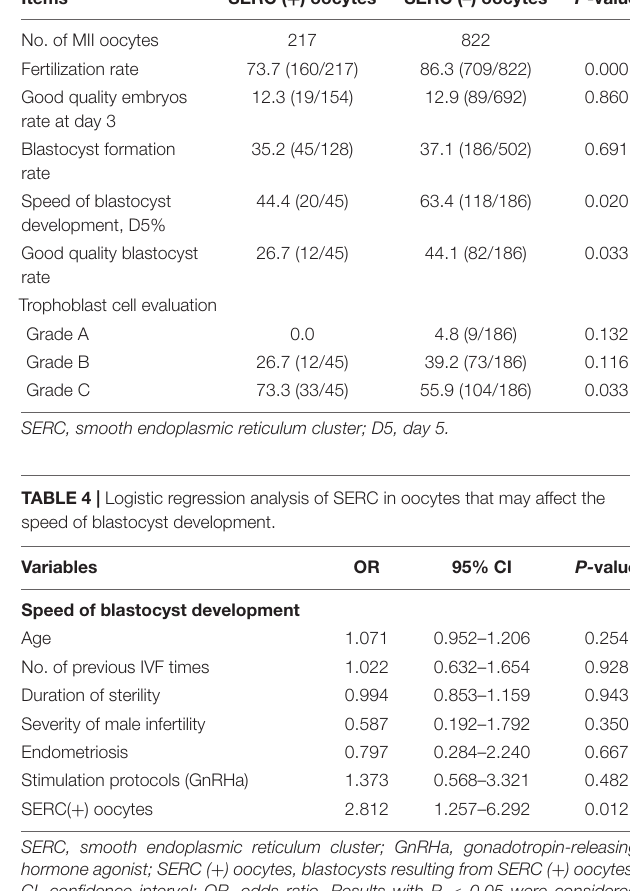
TABLE 3 | Comparison of embryonic outcomes between SERC ( + ) and SERC (–) oocytes in the SERC ( + ) cycle group. Items SERC ( + ) oocytes